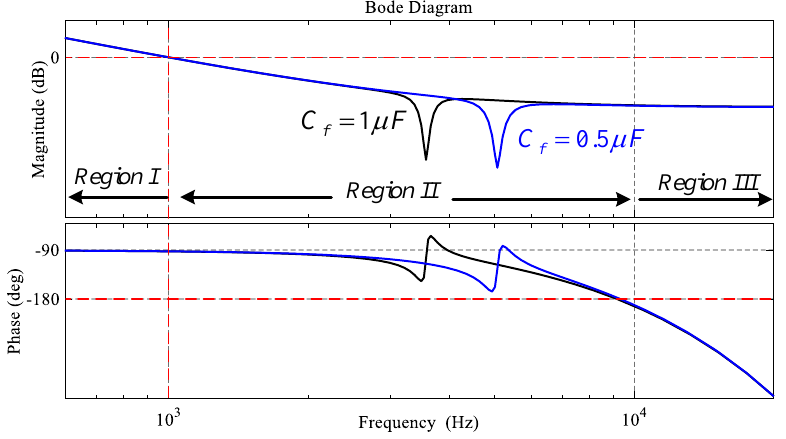
Figure 18. Loop gain Bode plots under different filter capacitance C fk of the LCL filter type GcI.